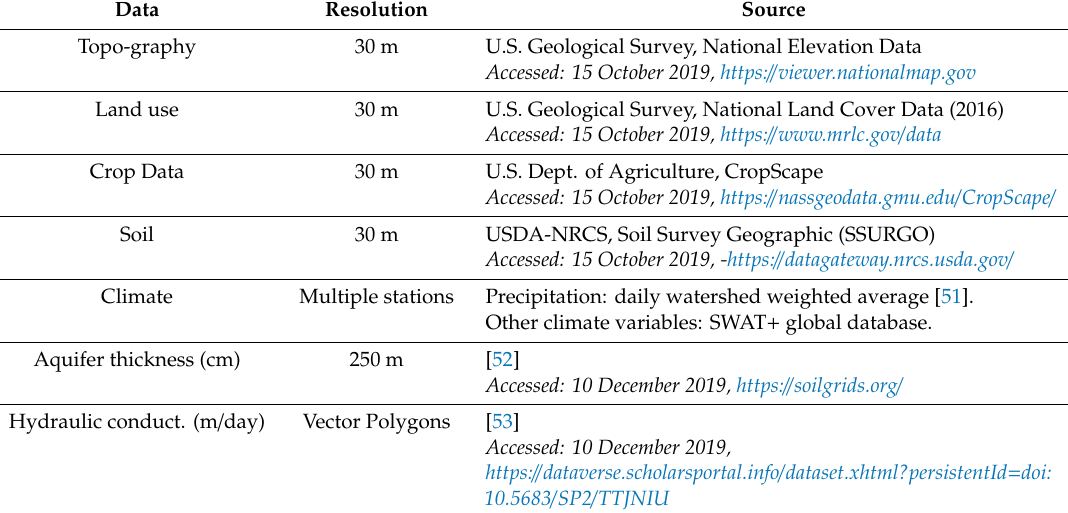
Table 3. Datasets and corresponding sources for the construction of the Little River Watershed SWAT +